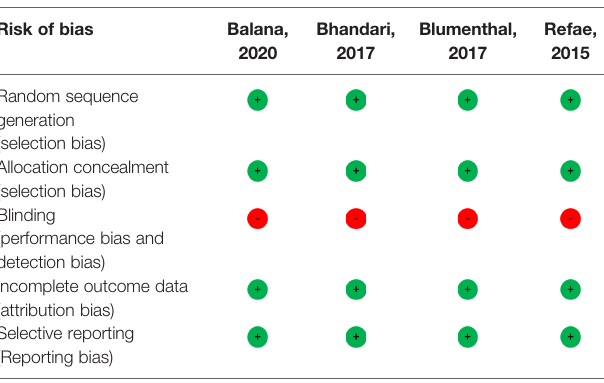
TABLE 1 | Methodological quality summary for the included